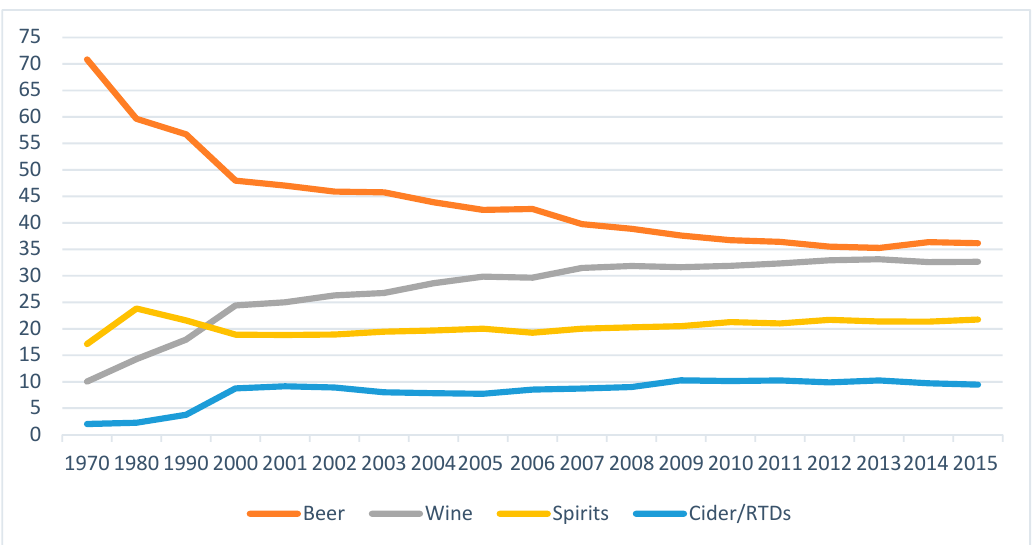
Figure 1. Share of UK alcohol consumption based on alcohol content. Source: Adapted from data supplied by British Beer and Pub Association, Statistical Handbook, 2016.